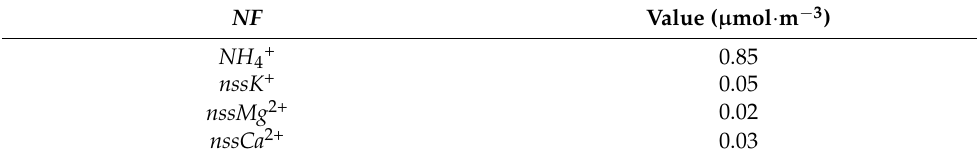
Table 3. The neutralization factors ( NF ) calculated for NH 4+ , nssK + , nssMg 2+ and nssCa 2+ .